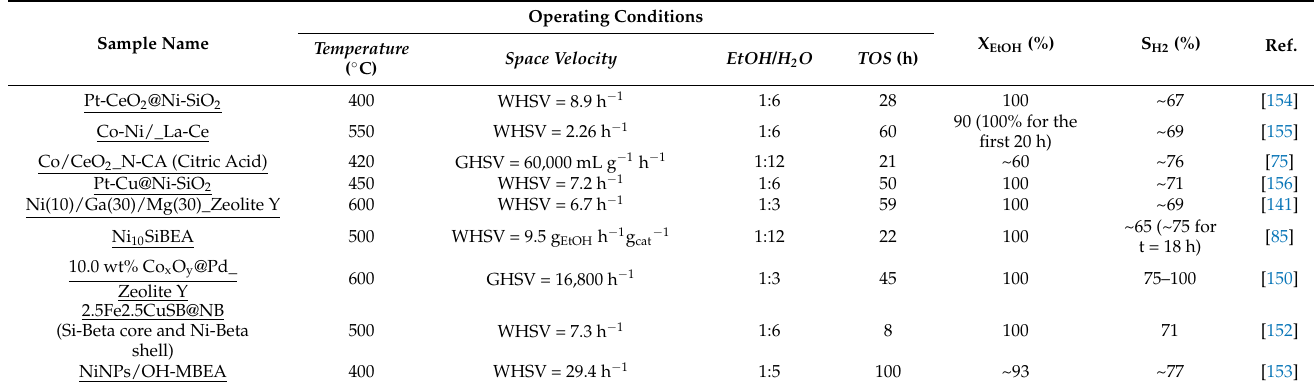
Table 7. Comparison of ESR catalytic performance among various catalytic